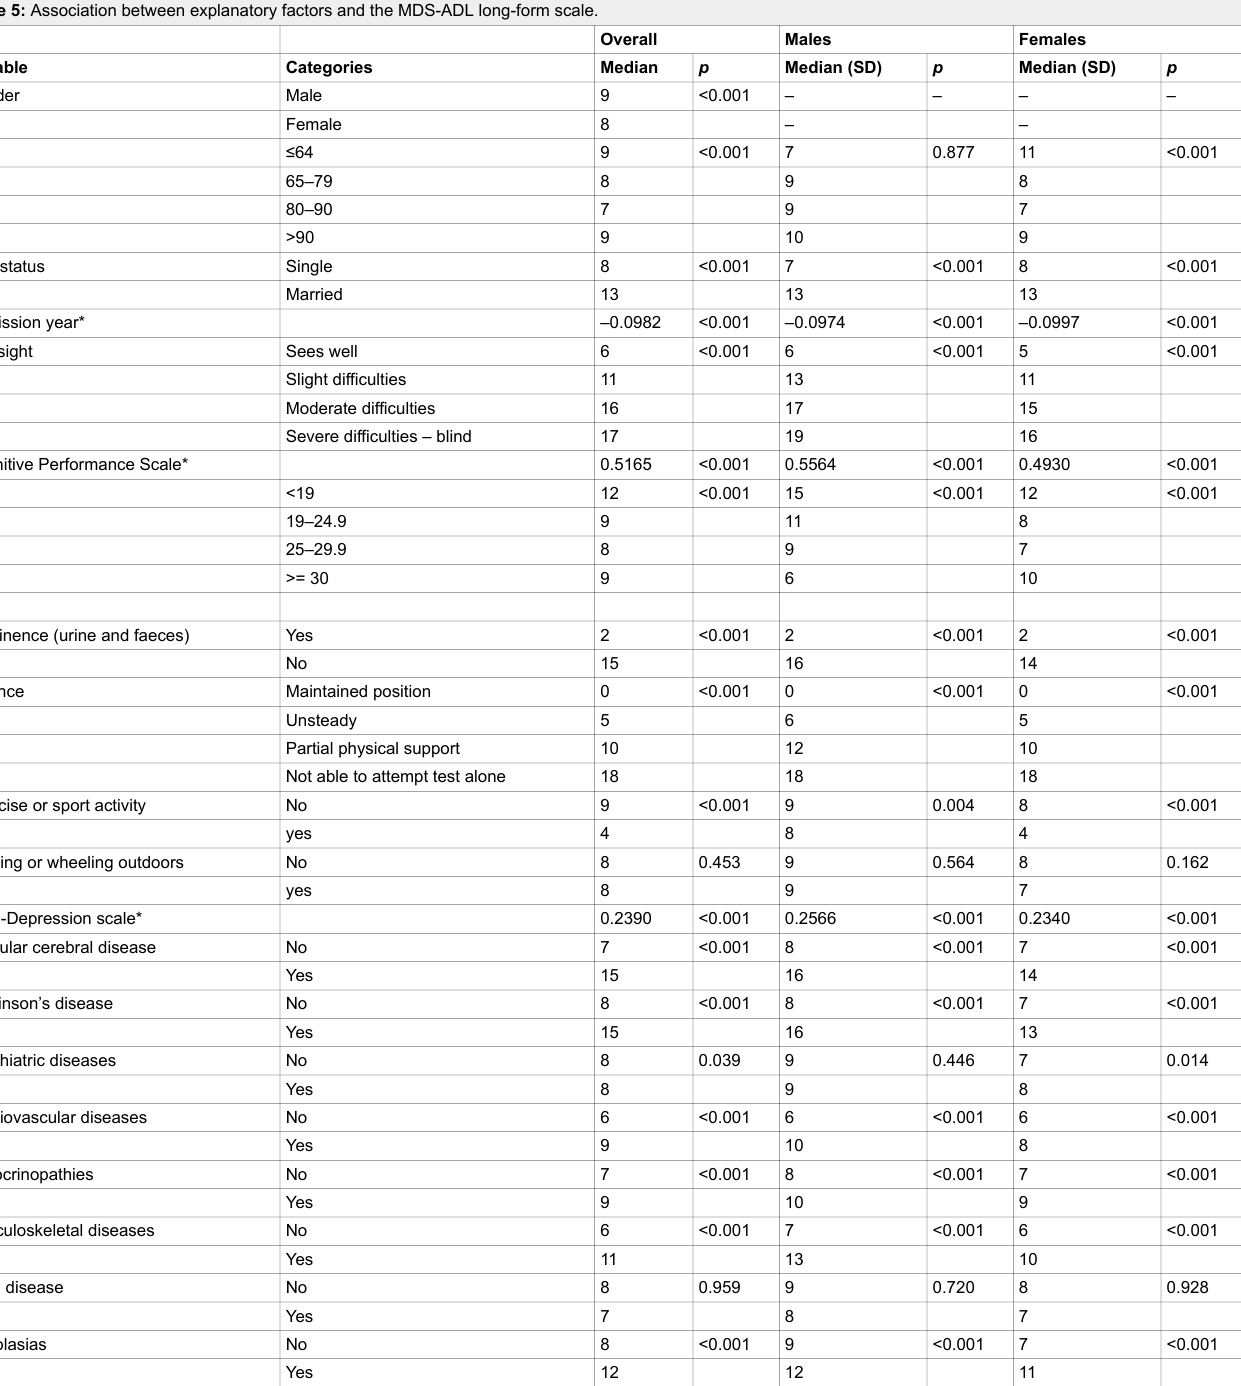
Table 5: Association between explanatory factors and the MDS-ADL long-form